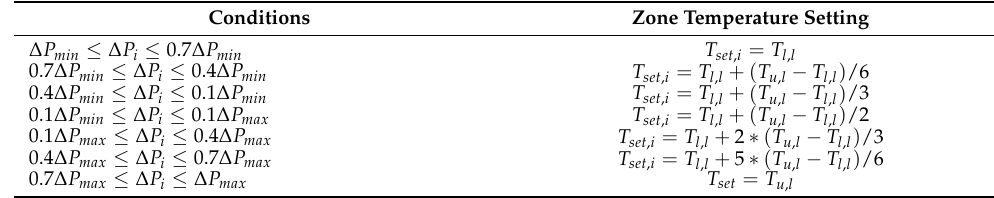
Table 1. Temperature setting in the rule-based demand response (DR) control strategy.